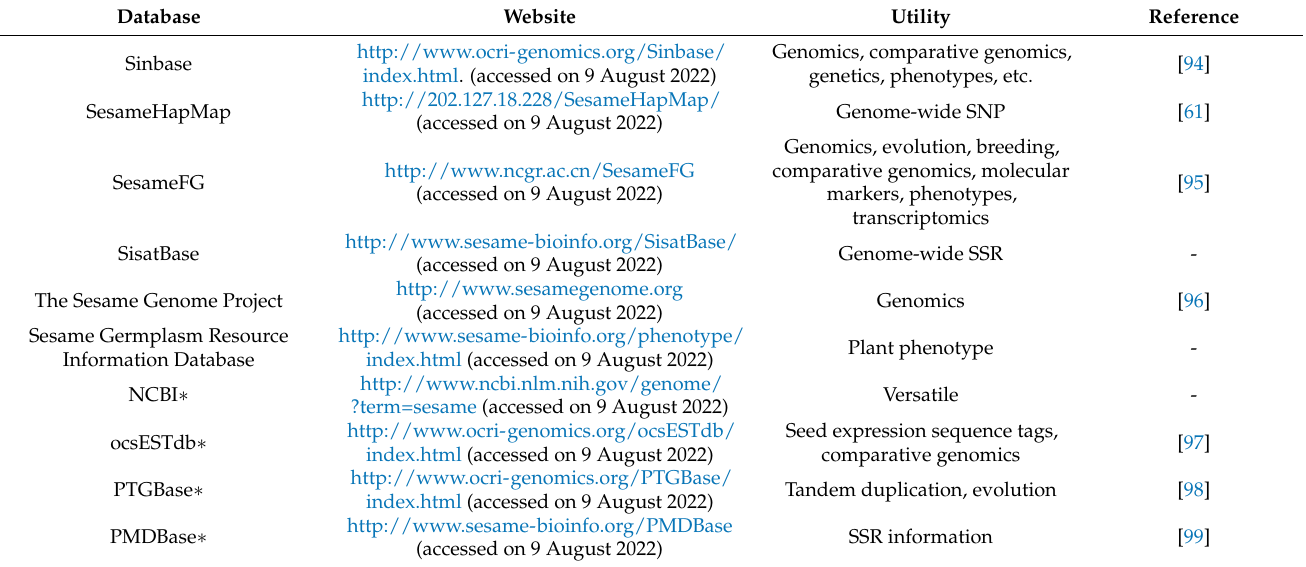
Table 6. Online genomic resources for